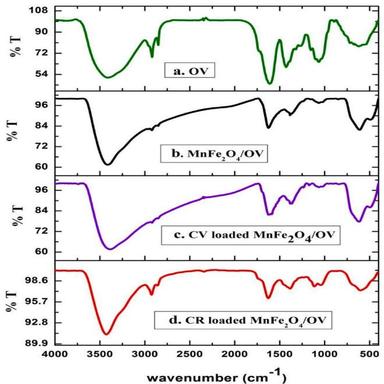
FT-IR spectrum of (a) Origanum vulgare (OV) leaves, (b) MnFe2O4/OV, (c) CV loaded MnFe2O4/OV, (d) CR loaded MnFe2O4/OV.